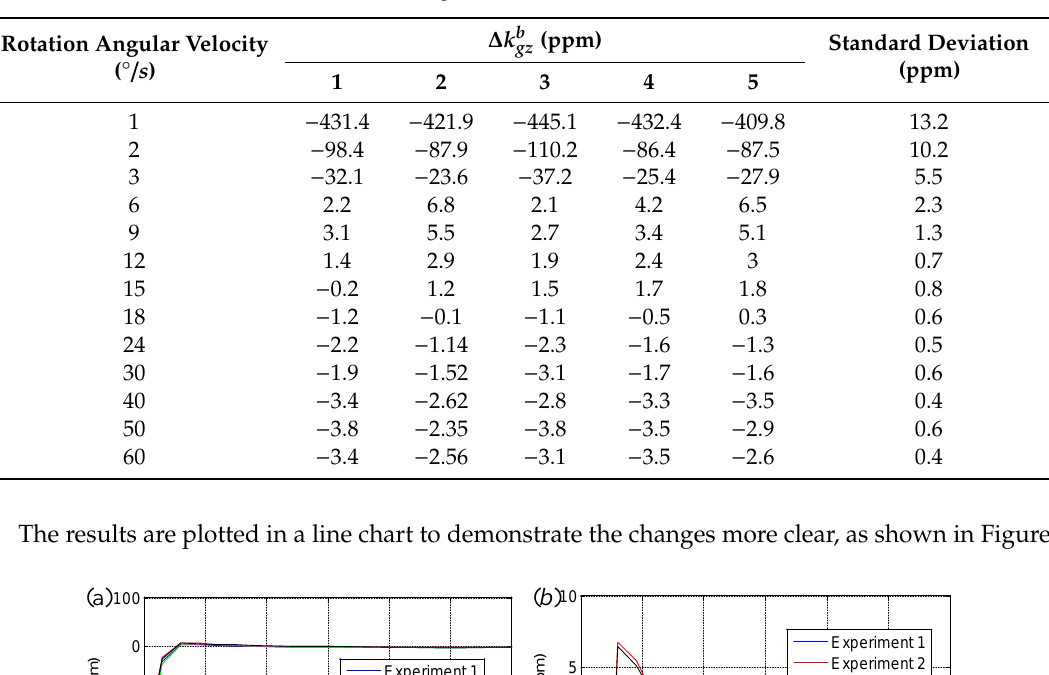
Table 3. Calibration results of ∆ k b gz in rate-biased mode using traditional method.